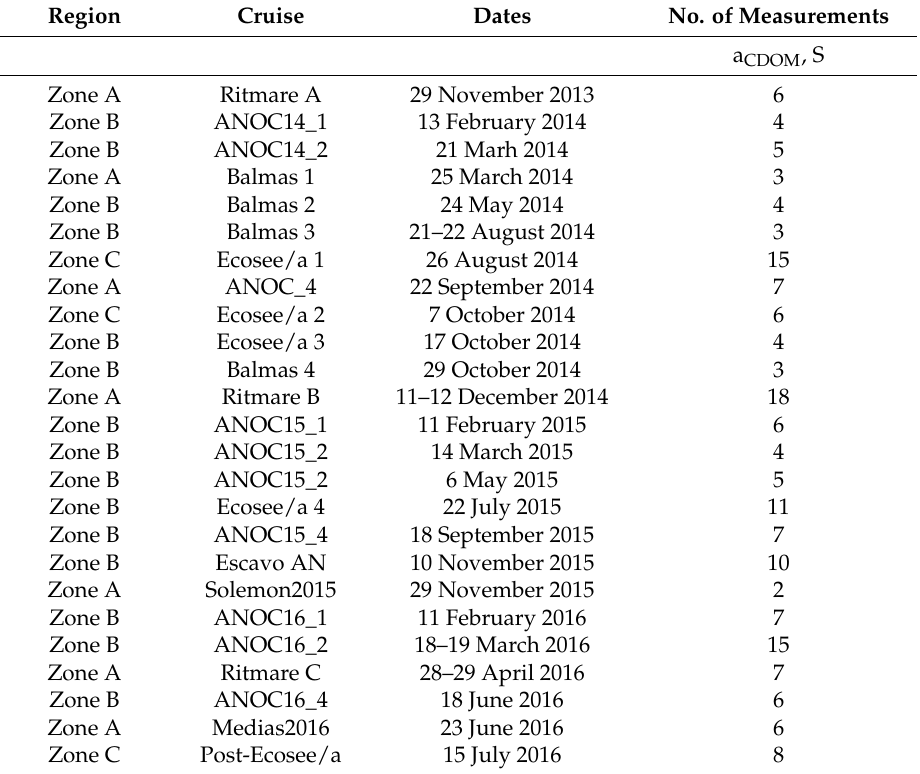
Table 1. List of field data from cruises for the absorption coefficient of Coloured Dissolved Organic Matter (a CDOM ) and salinity (S). Region Cruise